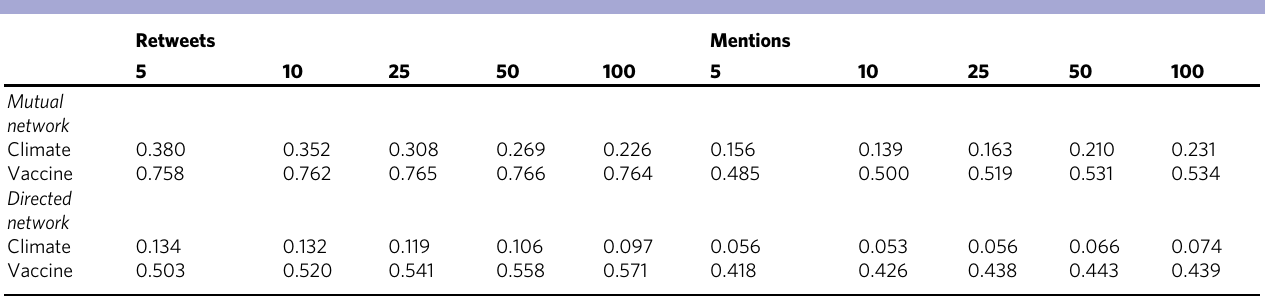
Fig. 1 The vaccine conversation is more assortative with respect to sentiment. Network of users tweeting 100 times or more in the climate change (top) and vaccine (bottom) conversations, for retweet (left) and mention (right) networks. Each node represents an individual user. Edges represent interactions between the users: a user has tweeted or mentioned another user. The color of the node represents the most common sentiment expressed by that user: green represents pro-, red represents anti- and yellow represents neutral. Table 4 The vaccine conversation exhibits higher levels of assortative